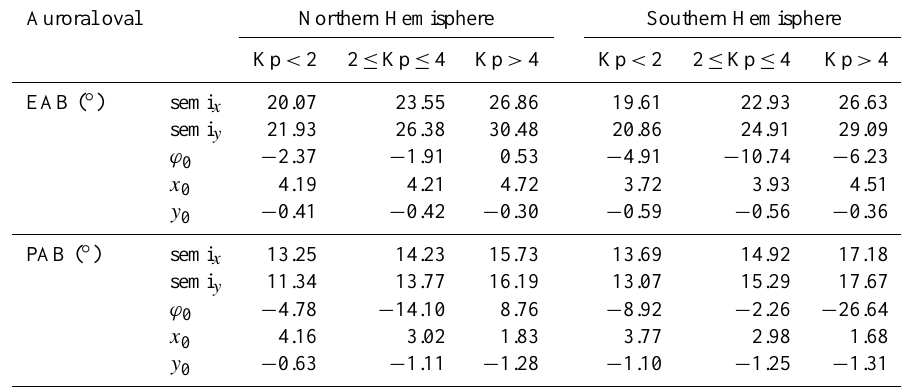
Table 1. The ellipse parameters of the auroral oval boundaries in both hemispheres for different magnetic activities. Auroral oval Northern Hemisphere Southern